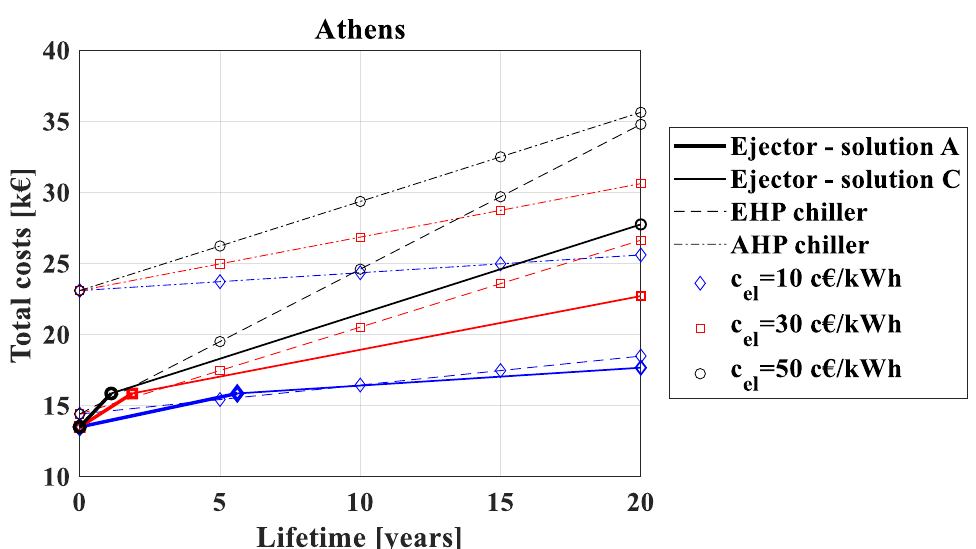
Figure 11. Total costs as function of economic lifetime and electric energy unit price for Athens climatic zone, and comparison between hybrid ejector cycle and current technology .